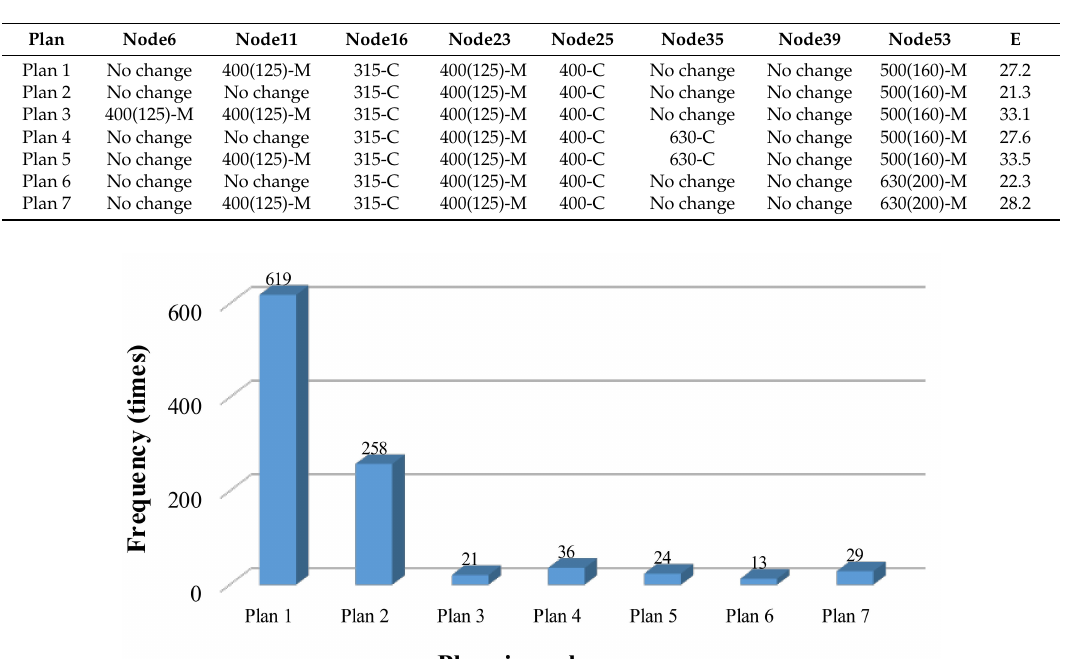
Table 11. Planning schemes of distribution transformers with nodal effective load considering uncertainties.